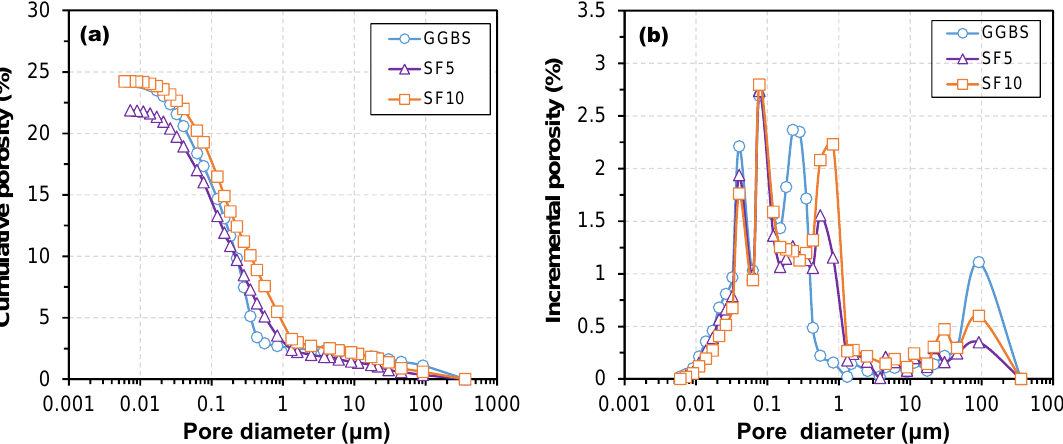
Figure 13. Cumulative ( a ) and incremental ( b ) MIP results of 28-day-aged GGBS, SF5, and SF10.